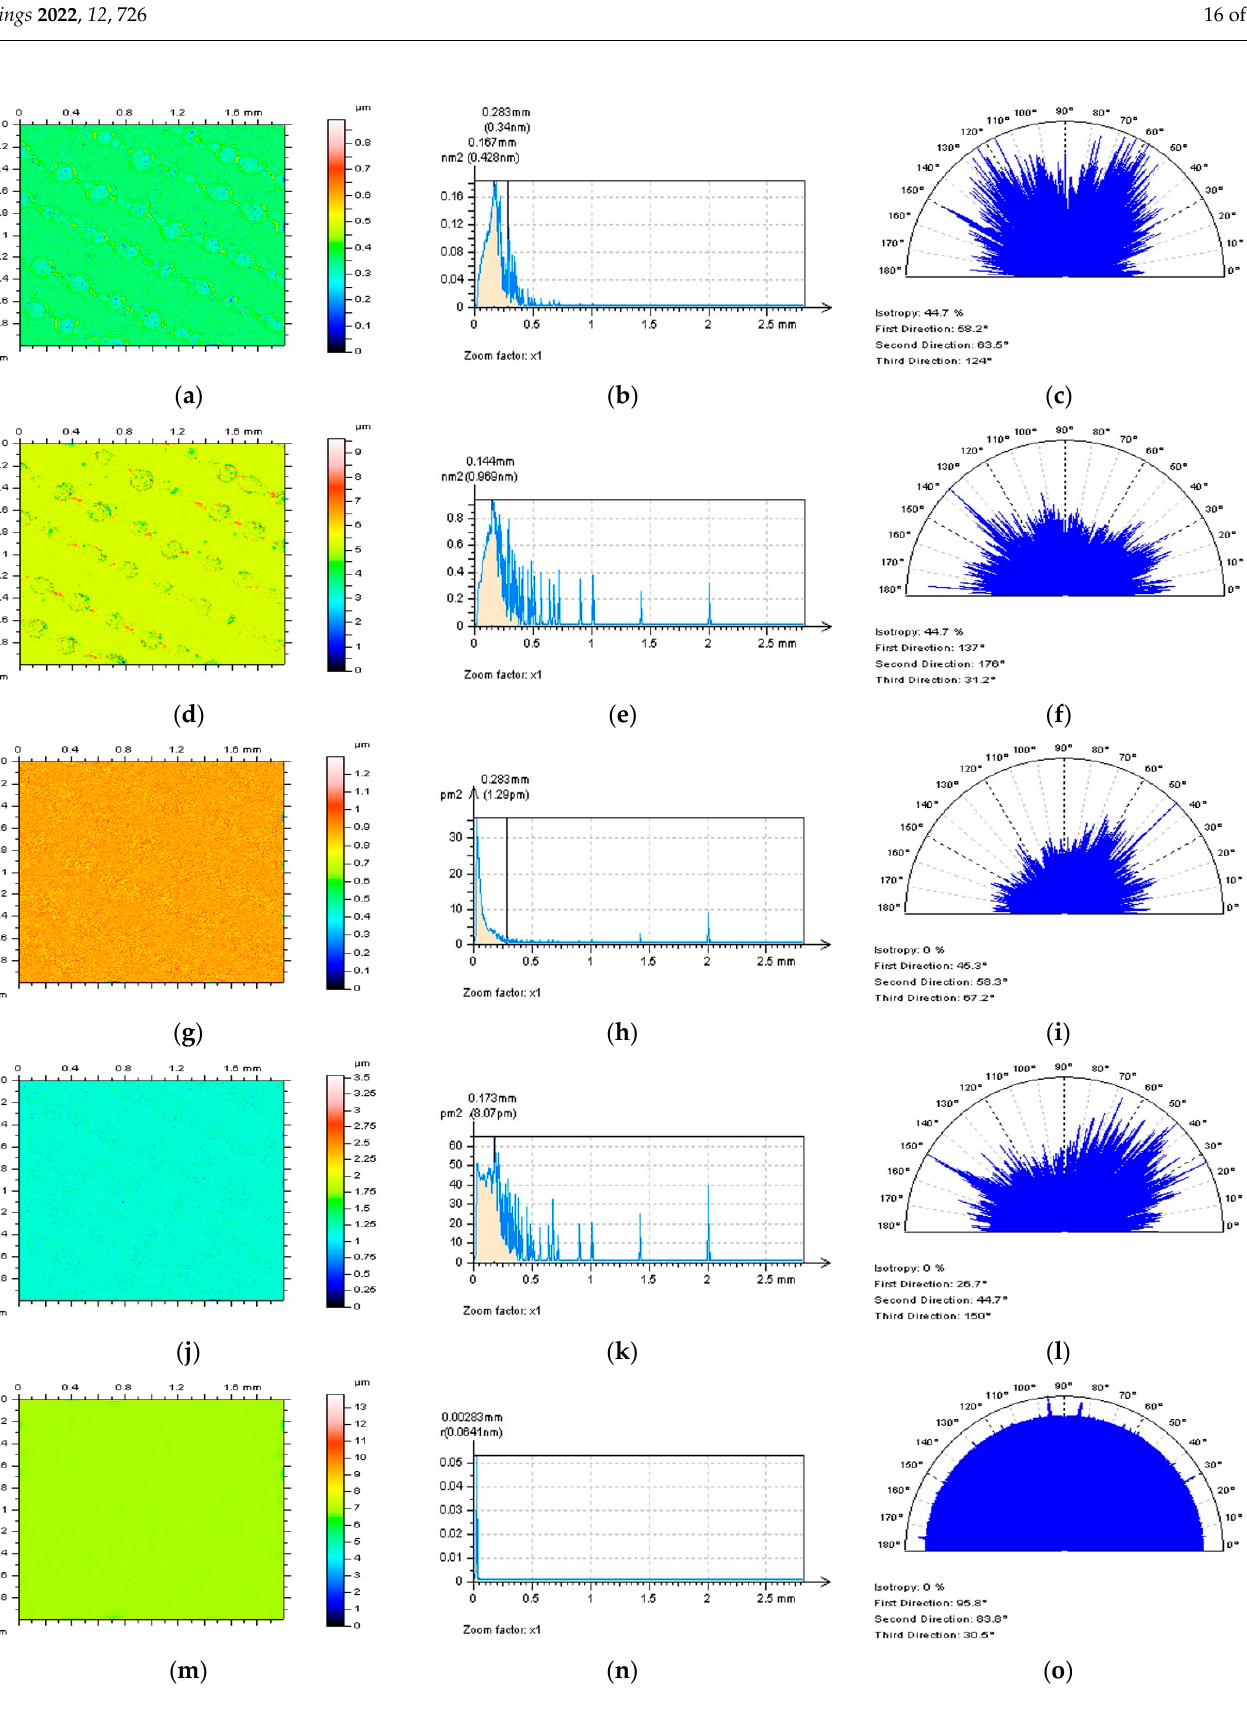
Figure 9. Analysis of a HFNS (left column), their PSDs (middle) and TDs (right column) received from a 30° left rotated laser ‐ textured surface by application of the following filtering method: GF